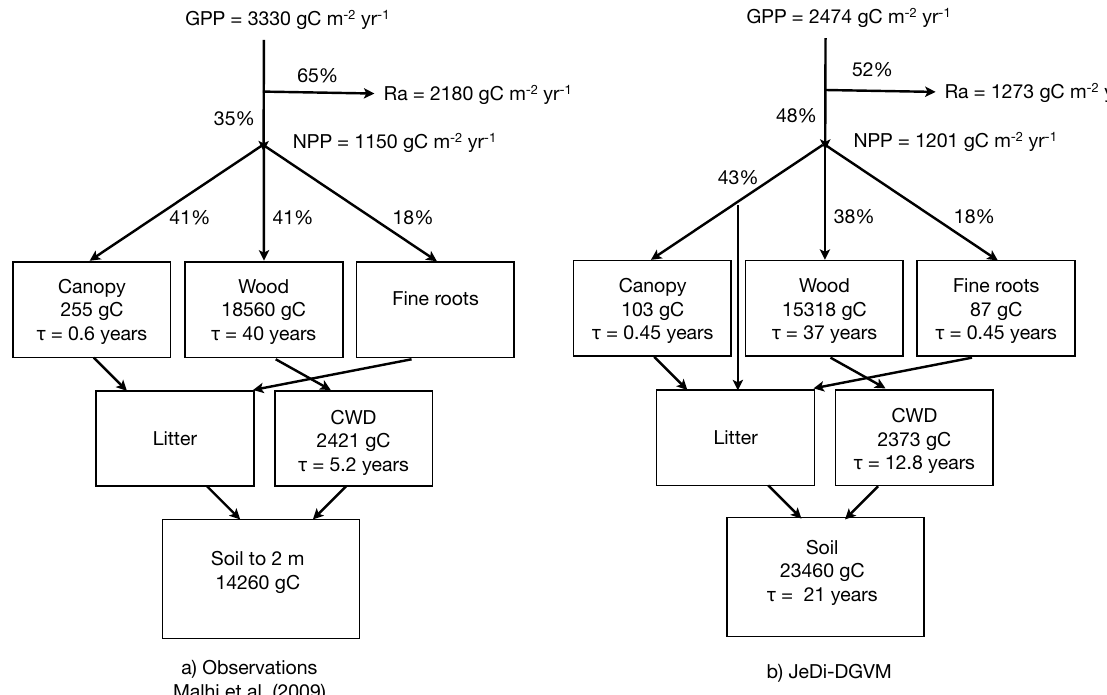
Fig. 7. Carbon pools and fluxes in Amazonia from (a) synthesis of observations (Malhi et al., 2009) and (b) as simulated by JeDi-DGVM for years 1980–2004. GPP, gross primary productivity; R a , autotrophic respiration; NPP, net primary productivity; CWD, coarse woody debris.